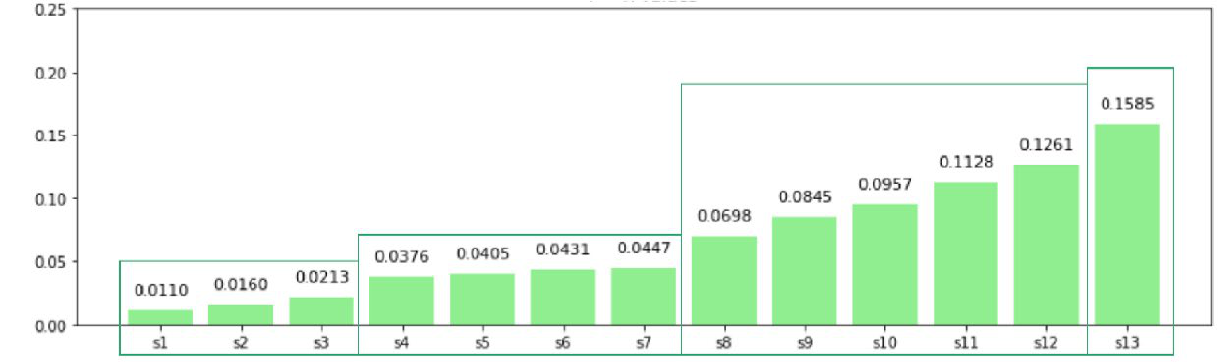
Figure 4. The VMD-SE process of case 1.